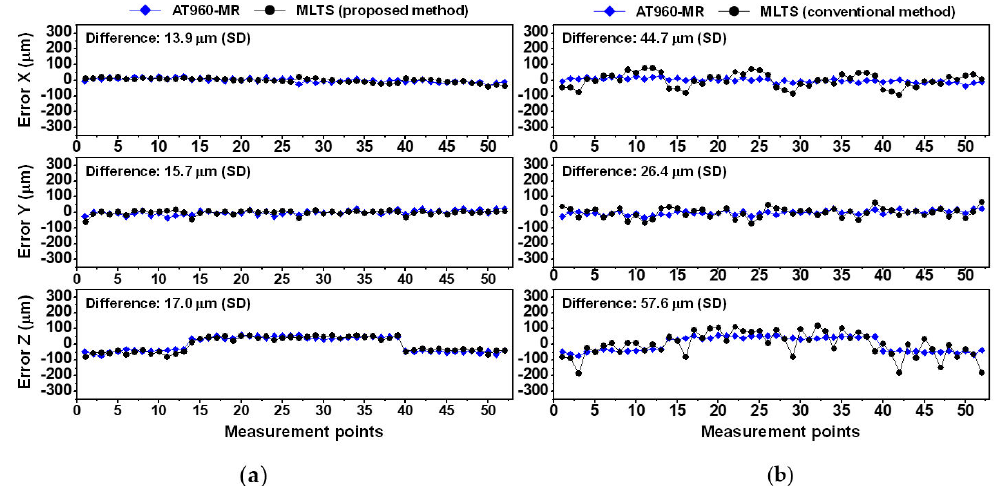
Figure 12. Comparisons of CMM errors measured by AT960-MR and MLTS in Experiment 2: ( a ) Proposed self-calibration method; ( b ) Conventional self-calibration